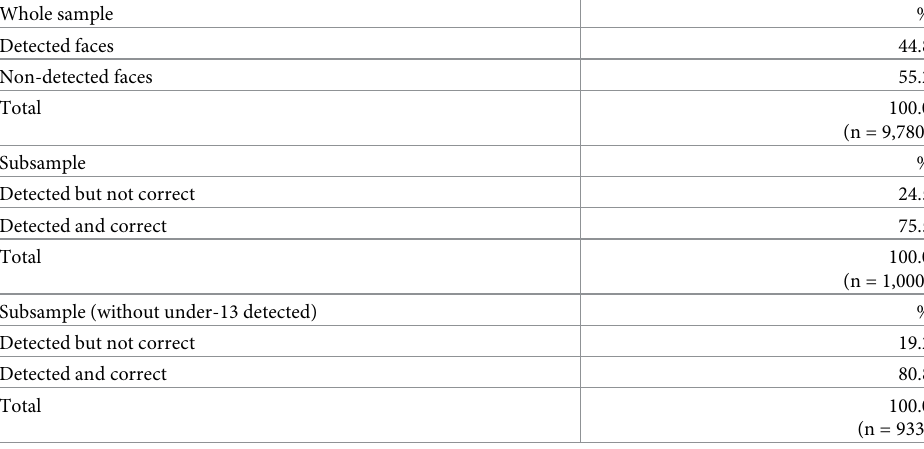
Table 1. Table rates of CNN face-detection